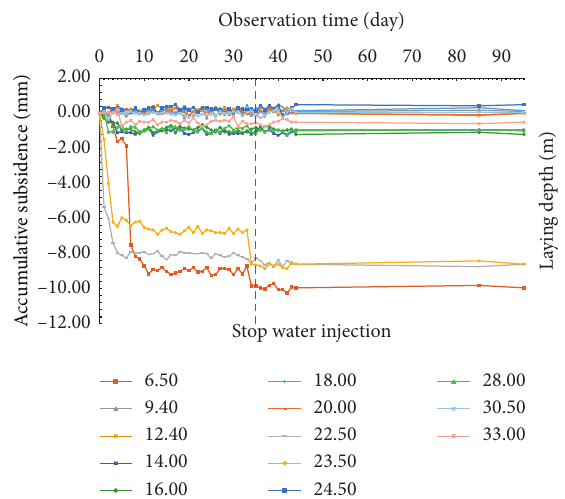
Figure 11: Accumulative surface subsidence curve of deep markers with different immersion days.